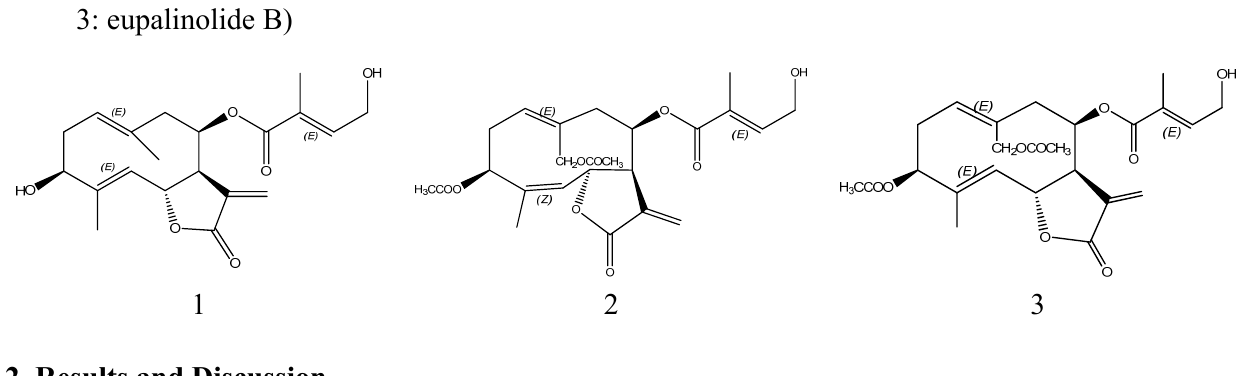
Figure 1. Chemical structures of three sesquiterpenoid lactones from